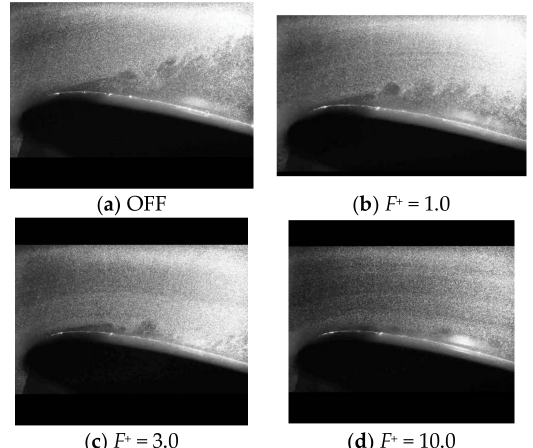
Figure 10. Instantaneous PIV particle images [39] (Experiment). NACA0015, α =12 ◦ , BR = 10%, Re = 6.3 × 10 4 .